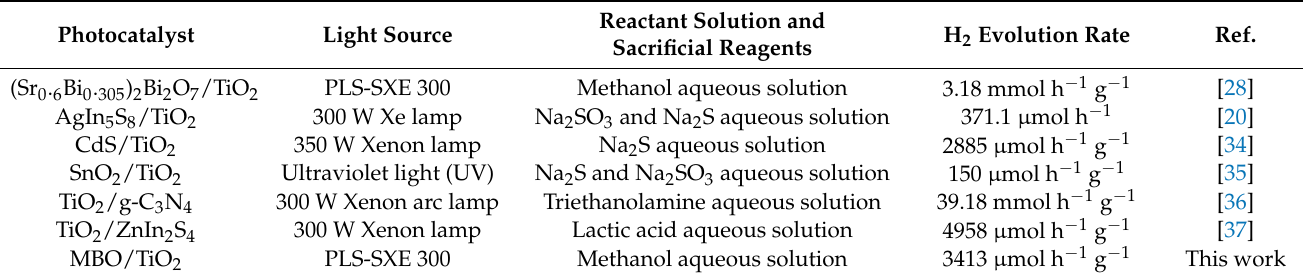
Table 1. A comparison of different TiO 2 composite photocatalysts for hydrogen production.